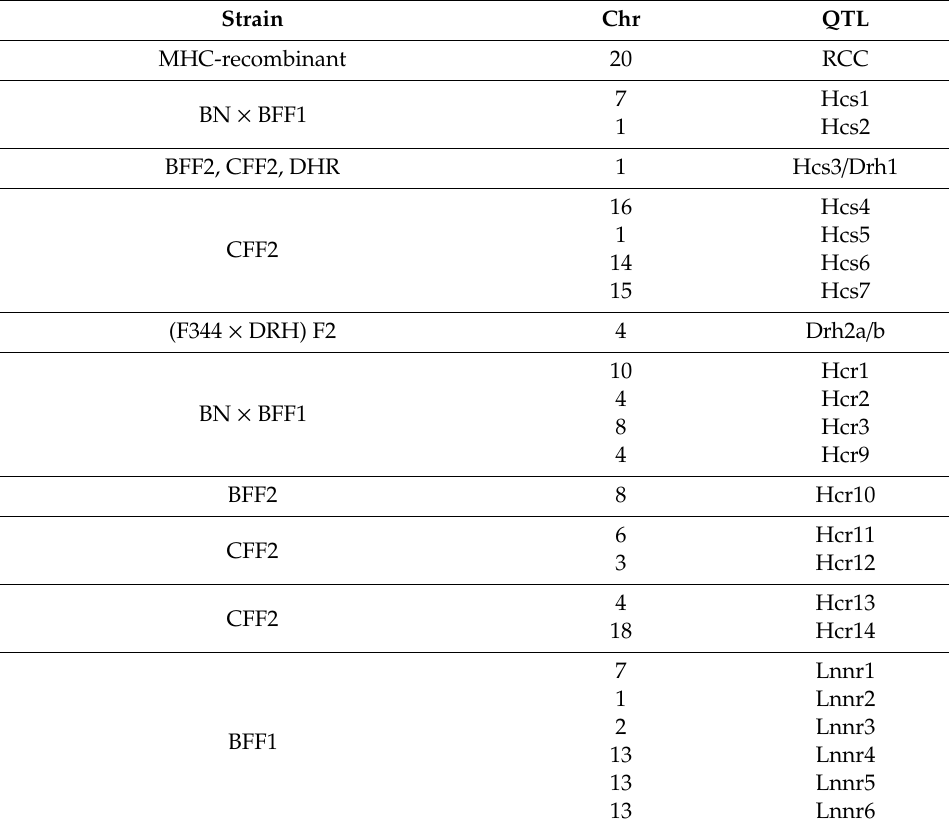
Table 2. QTLs regulating HCC development in